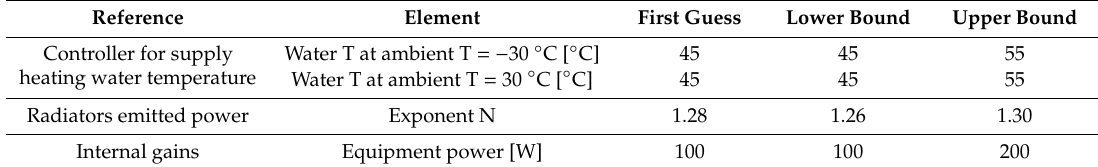
Table 11. Parameters collection for Calibration C.